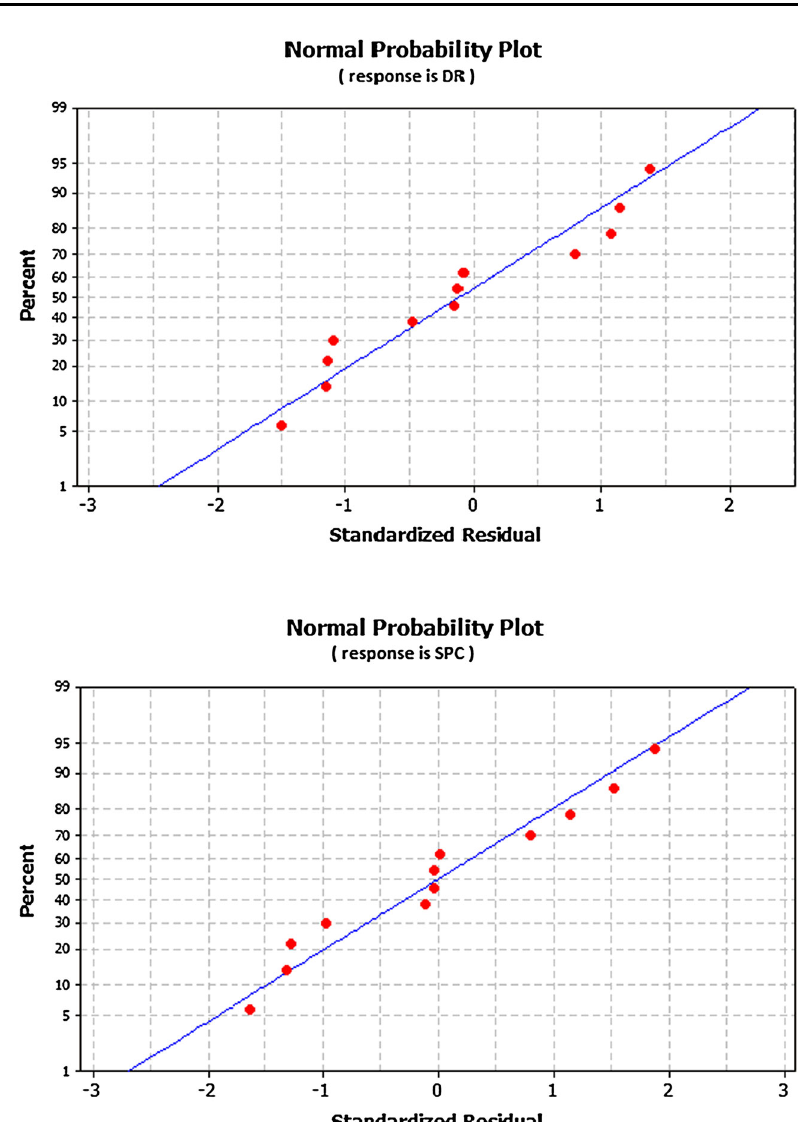
Fig. 8 Normal probability plot of the residuals for DR